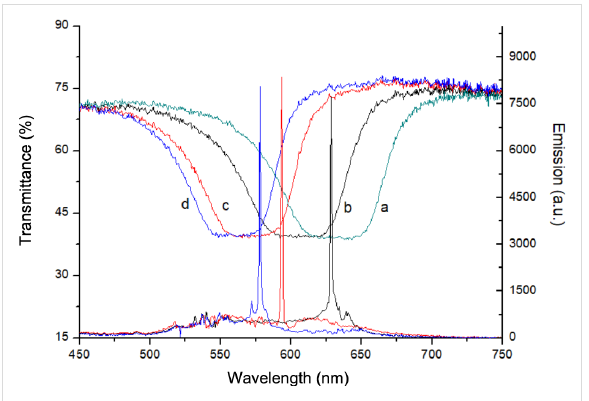
Figure 3: Blue shift of the emitted laser